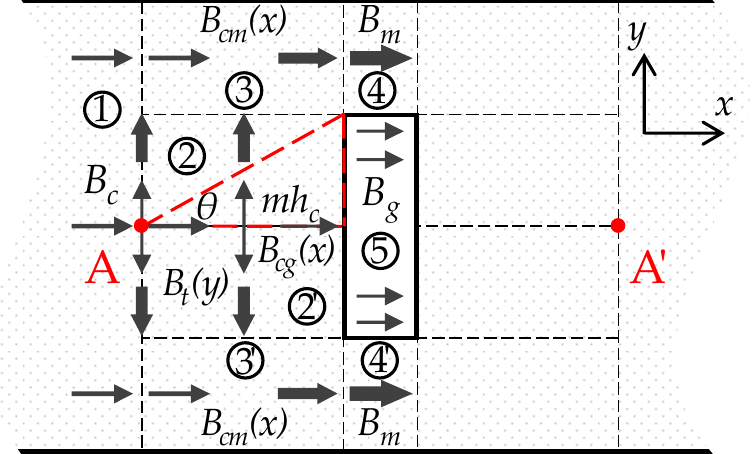
Figure 3. The magnetic flux density distribution around the air gap region.